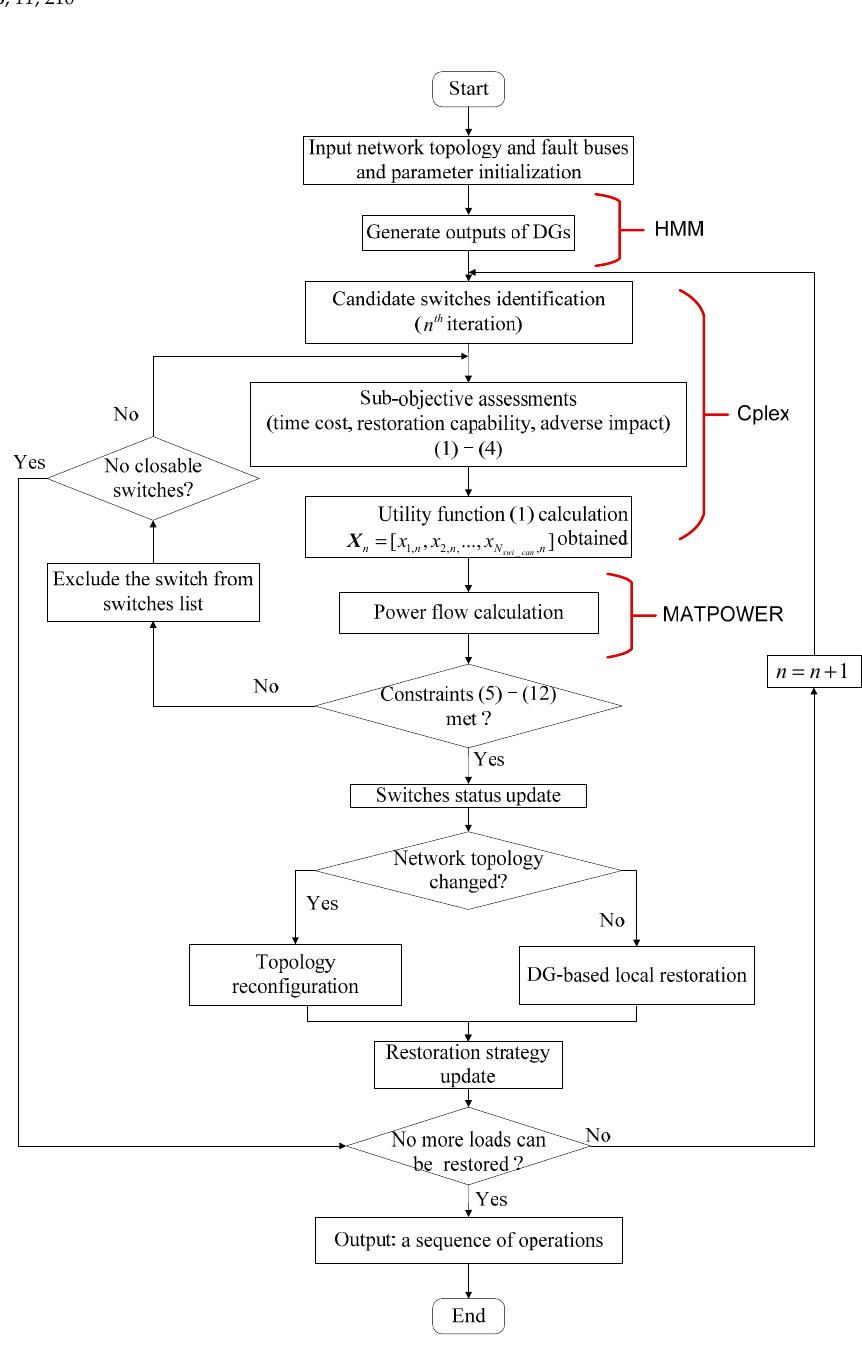
Figure 3. Flowchart of the proposed power supply restoration process.